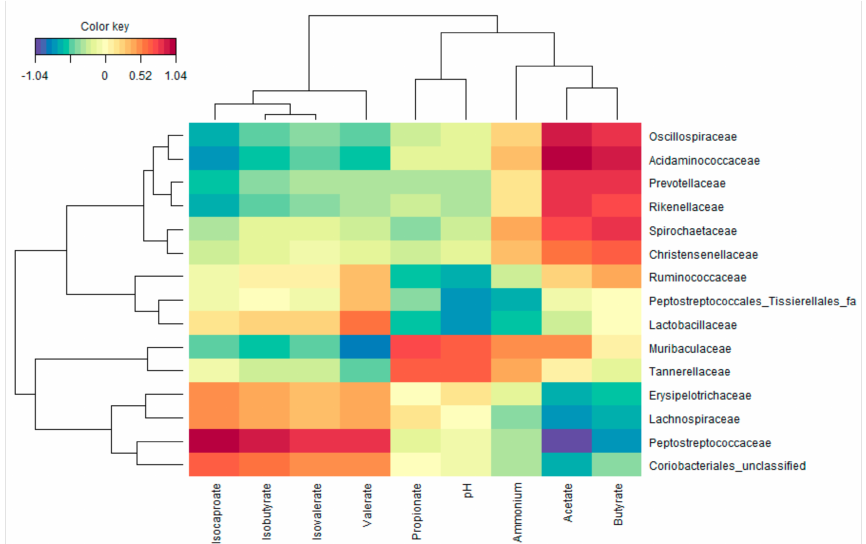
Figure 7. Relationship between bacterial families and pH, gas production, and fermentation products (SCFA, bCFA, and ammonium) in samples collected at the end of the 48 h incubation of the various amino acids with a porcine colonic microbiota. The heatmap was based on the regularized canonical correlation analysis (cutoff = 0.6) between bacterial abundances at family level (proportionate values,) and markers of microbial